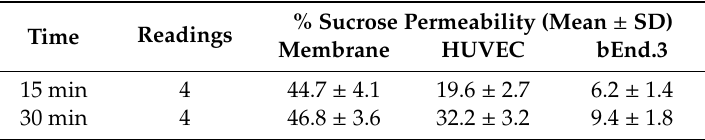
Table 1. Values of sucrose